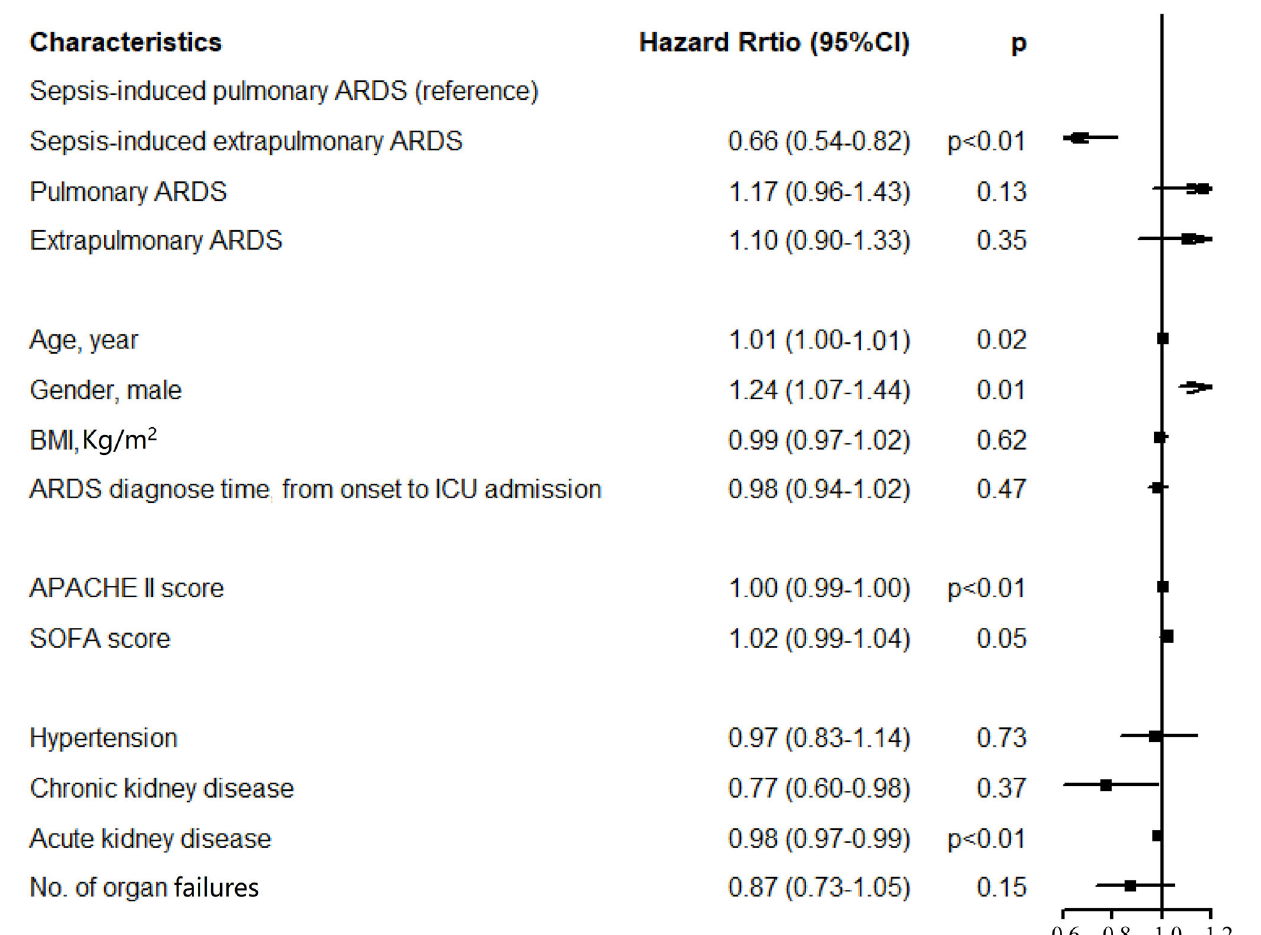
FIGURE 3 | Results of multivariate Cox regression analysis. After the proportional hazard assumption, APACHE II and morbidity with acute kidney injury were transformed into time-dependent